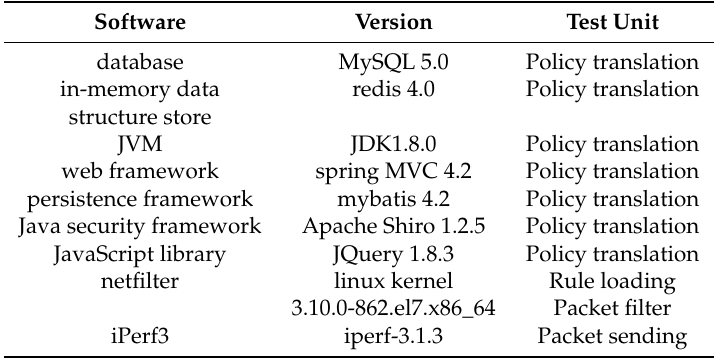
Table 2. The relation between test unit and running environment of